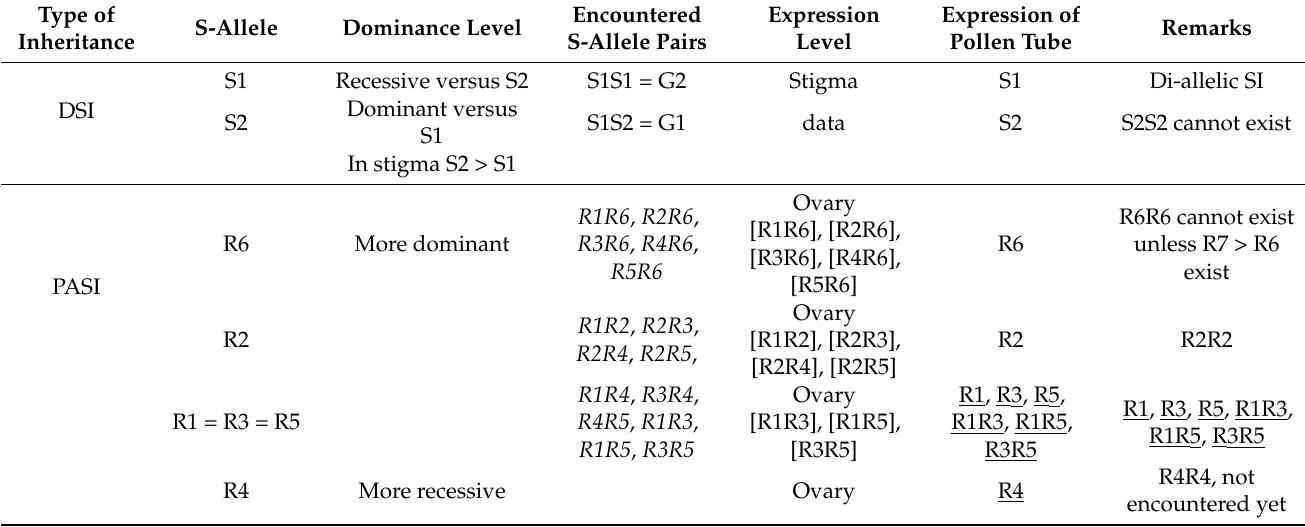
Table 3. Di-allelic self-incompatibility (DSI) and poly-allelic SI (PASI) models functioning at the pollen tube/stigma and pollen tube/ovary levels in the olive tree. DSI from Saumitou-Laprade et al. [12]; PASI from Breton et al. [10]. Type